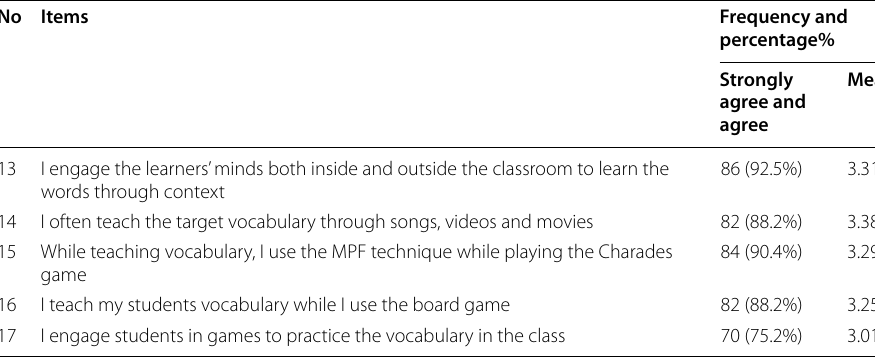
Table 4 Using games while teaching vocabulary No Items